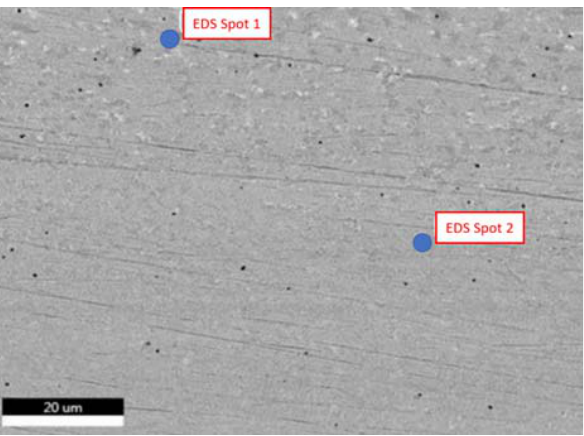
Figure 9. SEM image of specimen No. 1 with marked regions of compositional analysis.